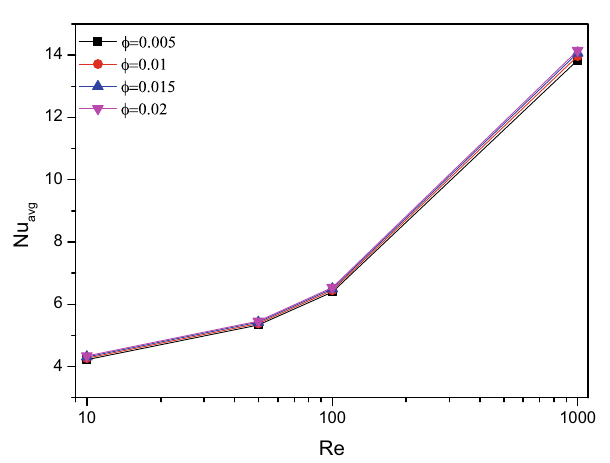
Figure 6. Variations of Nu avg with various Re for solid volume fraction variations ( ϕ ), Re = 1000 , Ri = 1